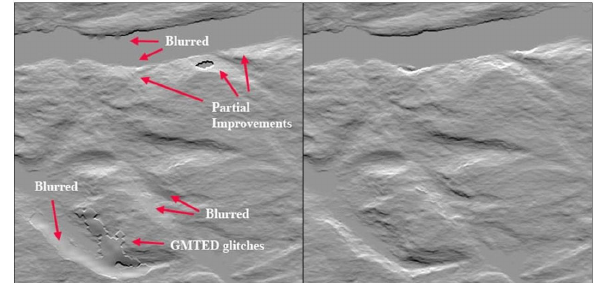
Figure 4. Global digital elevation model (GDEM) V3 tile N60E05; 400 by 400 pixel subarea. Left: Input GDEM with errors and artifacts, both original, and introduced in early attempt at correction. Right: Final GDEM tile after